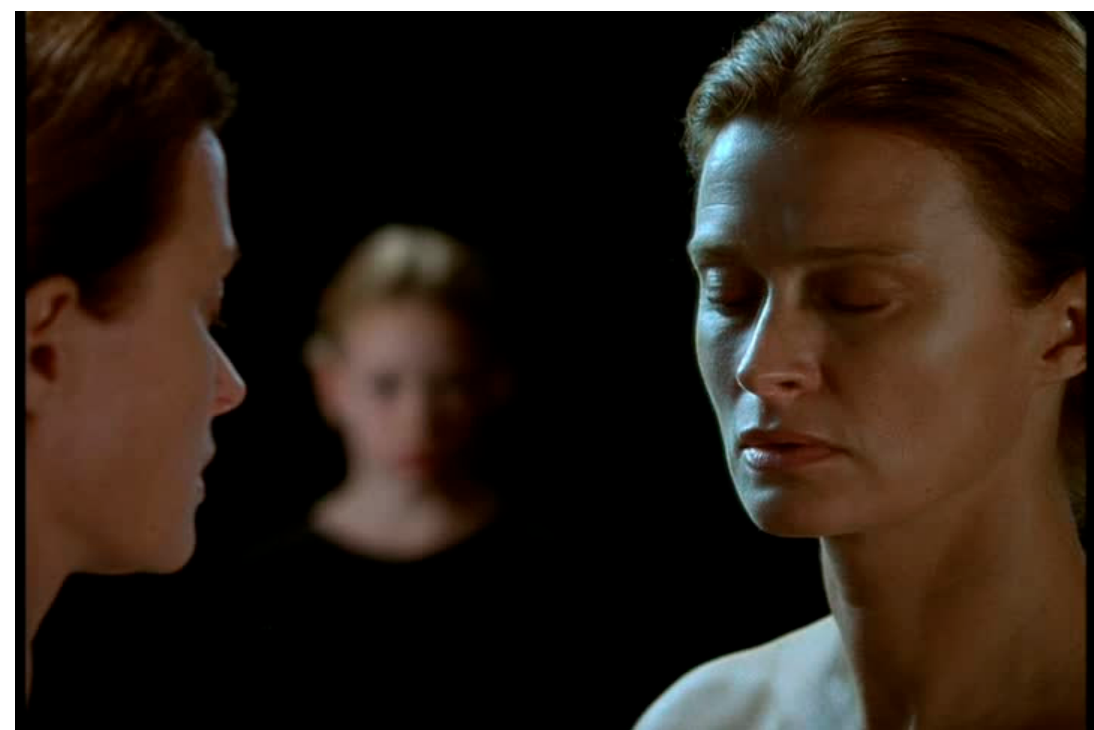
Figure 4. Marianne battles with herself, Isabelle in the midst..